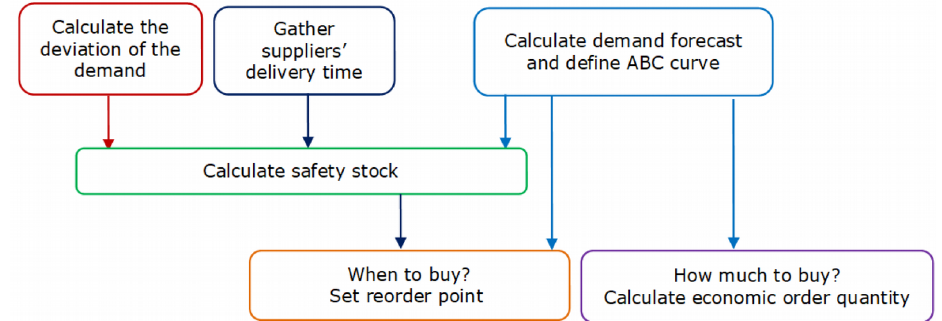
Figure 2. Diagram of the methods applied in the study